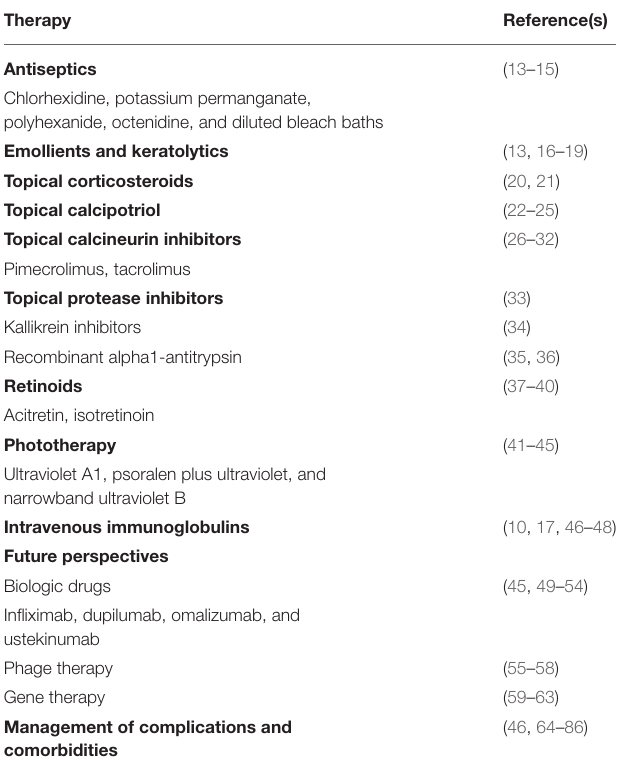
TABLE 1 | Summary of the different therapeutic strategies accessible and potentially available in the future for Netherton syndrome.